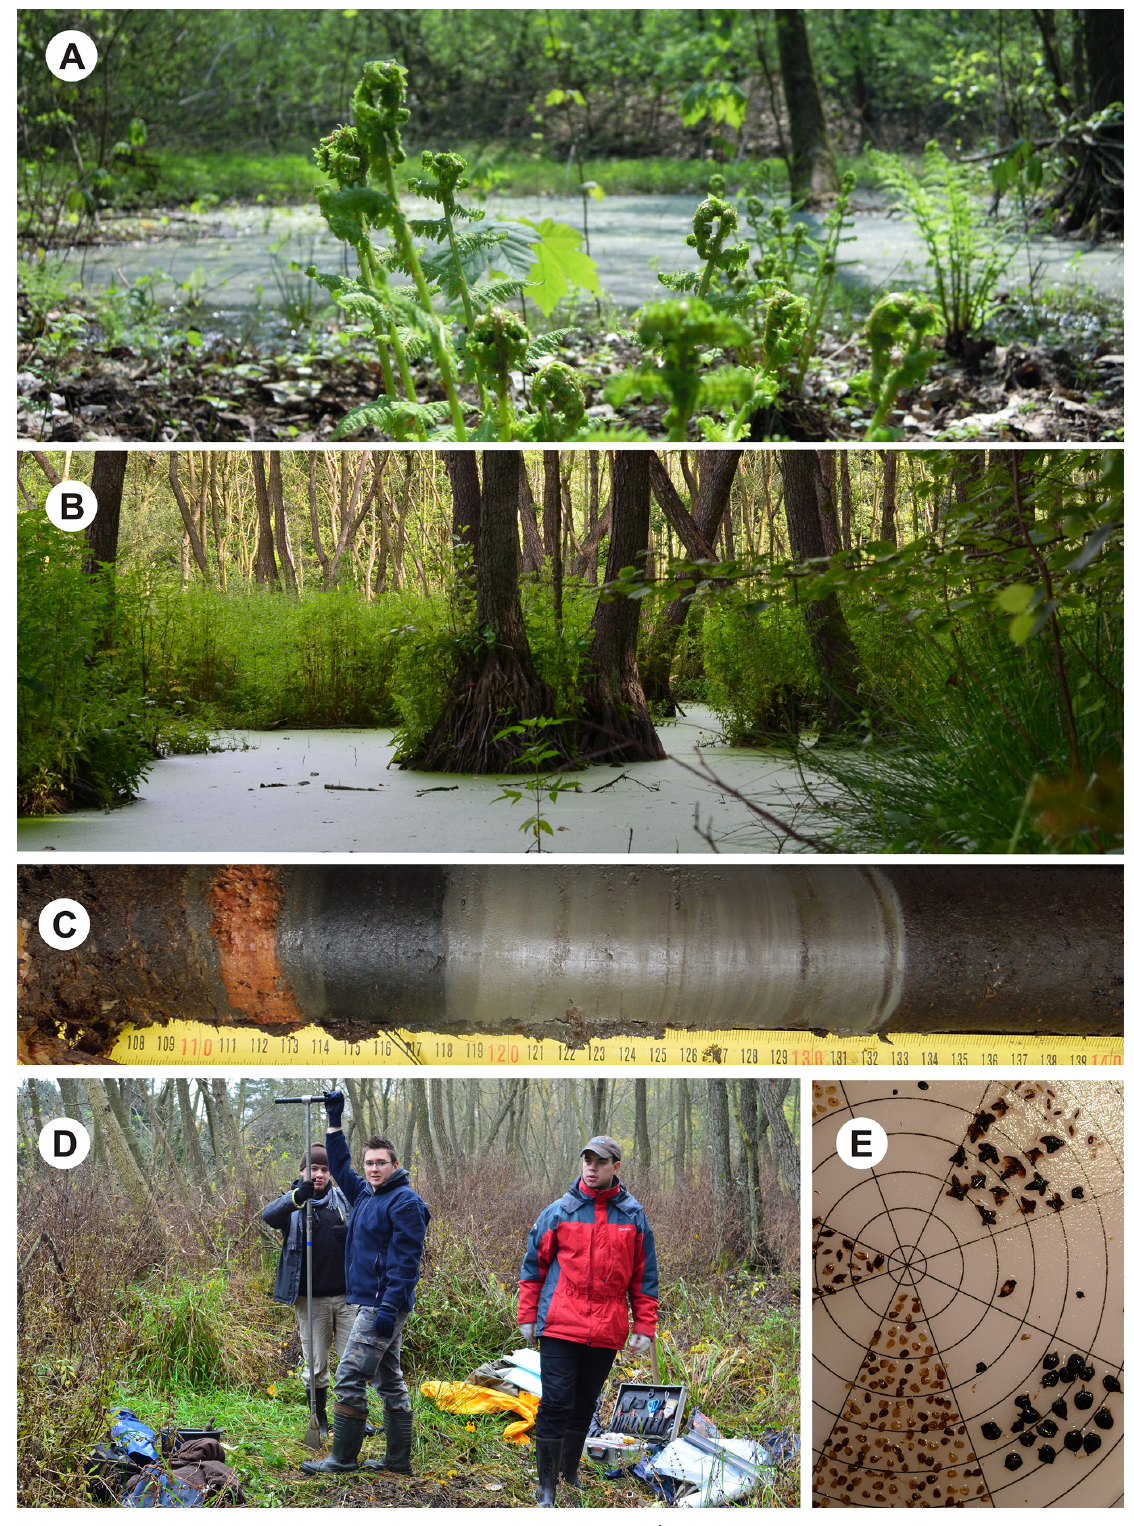
Fig. 13. Proposed urban geosite of the Żurawiniec peat